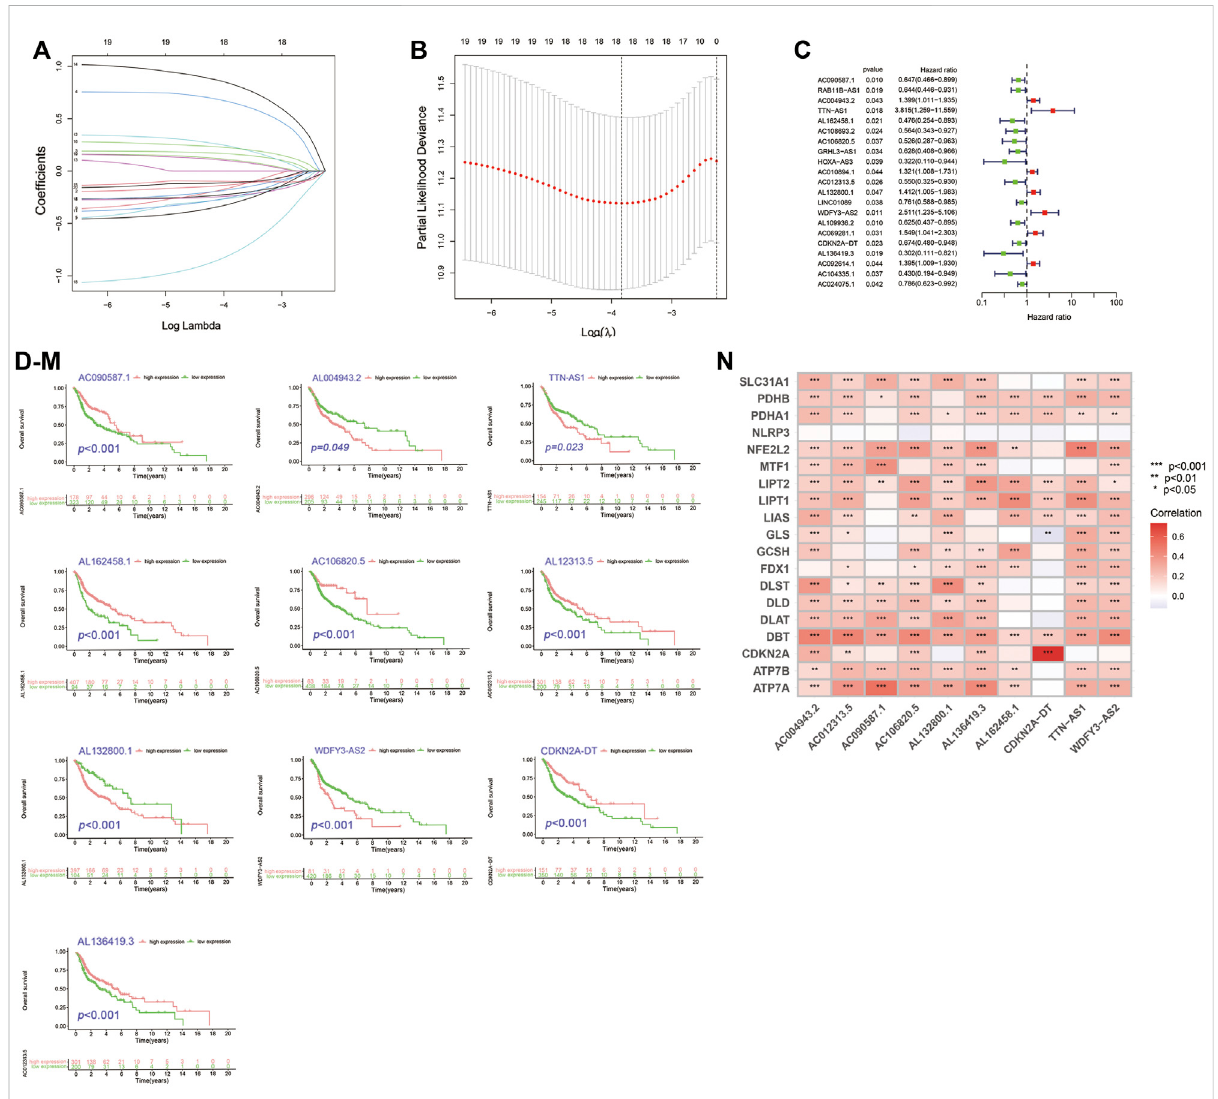
FIGURE 2 Construction of Cupr-RLs prognostic signature in HNSC. (A) The least absolute shrinkage and selection operator (LASSO) Cox regression analysis. (B) Lasso coef fi cient valuesandverticaldashedlineswerecalculatedatthebestlog(lambda)value. (C) UnivariateCox regressionanalysissupportedthe remarkable prognostic signi fi cance of the Cupr-RLs. (D – M) K – M curves showed different OS with different expression levels of the 10 Cupr-RLs. (N) Corrplot displayed the relationship between the 10 Cupr-RLs with 19 cuproptosis-related genes. * p < 0.05, ** p < 0.01, *** p <